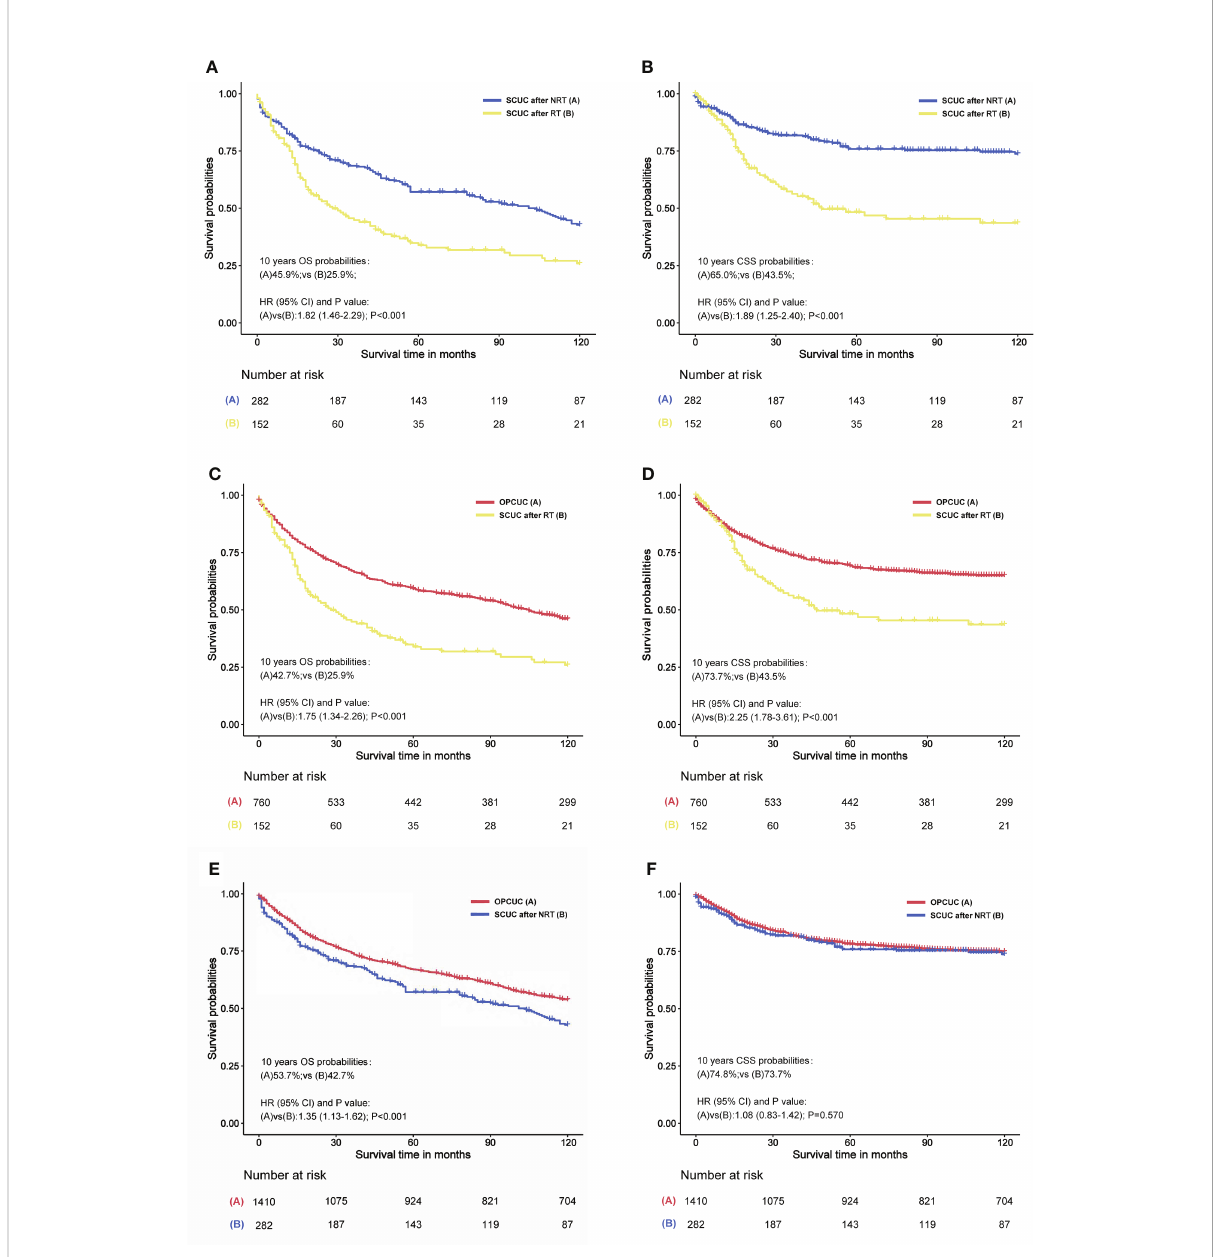
FIGURE 5 (A) Overall survival (OS) comparison between primary pelvic cancers (PPC) patients who developed secondary corpus uteri cancer (SCUC) after radiation therapy (RT) and PPC patients who developed SCUC after no RT (NRT). (B) Cancer-speci fi c survival (CSS) comparison between PPC patients who developed SCUC after RT and PPC patients who developed PPC after NRT. (C) OS comparison between PPC patients who developed SCUC after RT and patients with only primary corpus uteri cancer (OPCUC). (D) CSS comparison between PPC patients who developed SCUC after RT and patients with OPCUC. (E) OS comparison between PPC patients who developed SCUC after NRT and patients with OPCUC. (F) CSS comparison between PPC patients who developed SCUC after NRT and patients with OPCUC. (C – F) Case-control comparisons, PPC patients who developed SCUC (case group) versus patients with OPCUC (control group), with a PSM ratio of 1:5 for SCUC versus OPCUC. The variables matched for PSM included age at CUC diagnosis, year of CUC diagnosis, race, stage of CUC, and type of treatment for CUC. The detailed patient characteristics of OPCUC before and after PSM are shown in Supplementary Table S5. HRs were calculated by Cox regression. HR, hazard ratio; OPCUC, only primary corpus uteri cancer; RT, radiation therapy; CI, con fi dence interval; SCUC, secondary corpus uteri cancer; OS, overall survival; CSS, cancer-speci fi c